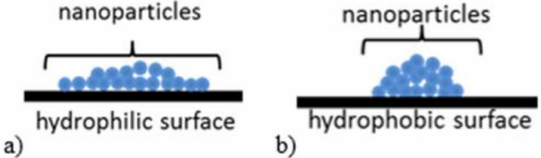
Figure 10. A scheme of the ZnO NPs on: ( a ) hydrophilic; and ( b ) hydrophobic surface after